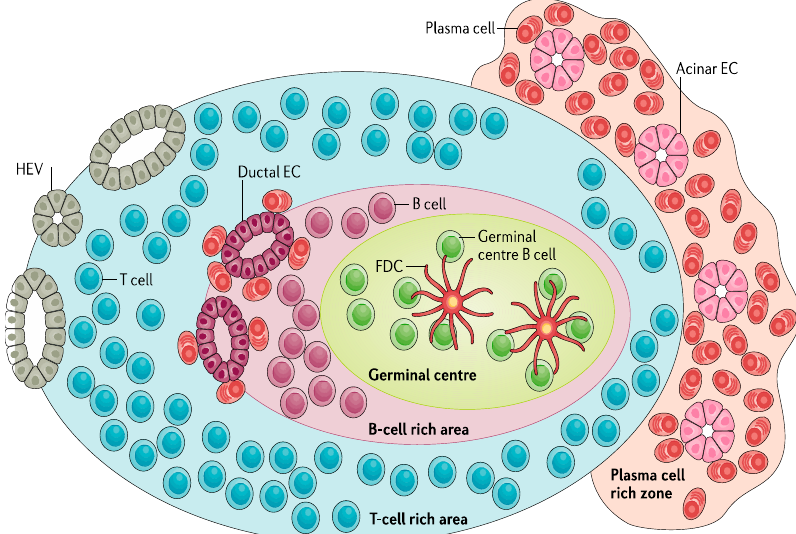
Figure 2. Schematic representation of an ectopic lymphoid-like structure (ELS), Segregation of T cells surrounding B cells. Development of high endothelial venules (HEVs) at the periphery of the ELS that enable lymphocytes expressing L-selectin to enter from the blood. Networks of follicular dendritic cells (FDCs) that support the germinal center response which expresses CD21 to facilitate the activation of B cells. Differentiation of hypermutated and class-switched plasma cells, which typically acquire a perifollicular localization with frequent infiltration of epithelial cells (ECs) from the ducts and acini. Reprinted by permission from Springer Nature Customer Service Centre GmbH: MDPI AG, Nature Reviews Rheumatology, Ectopic lymphoid neogenesis in rheumatic autoimmune diseases, Michele Bombardieri et al., COPYRIGHT,